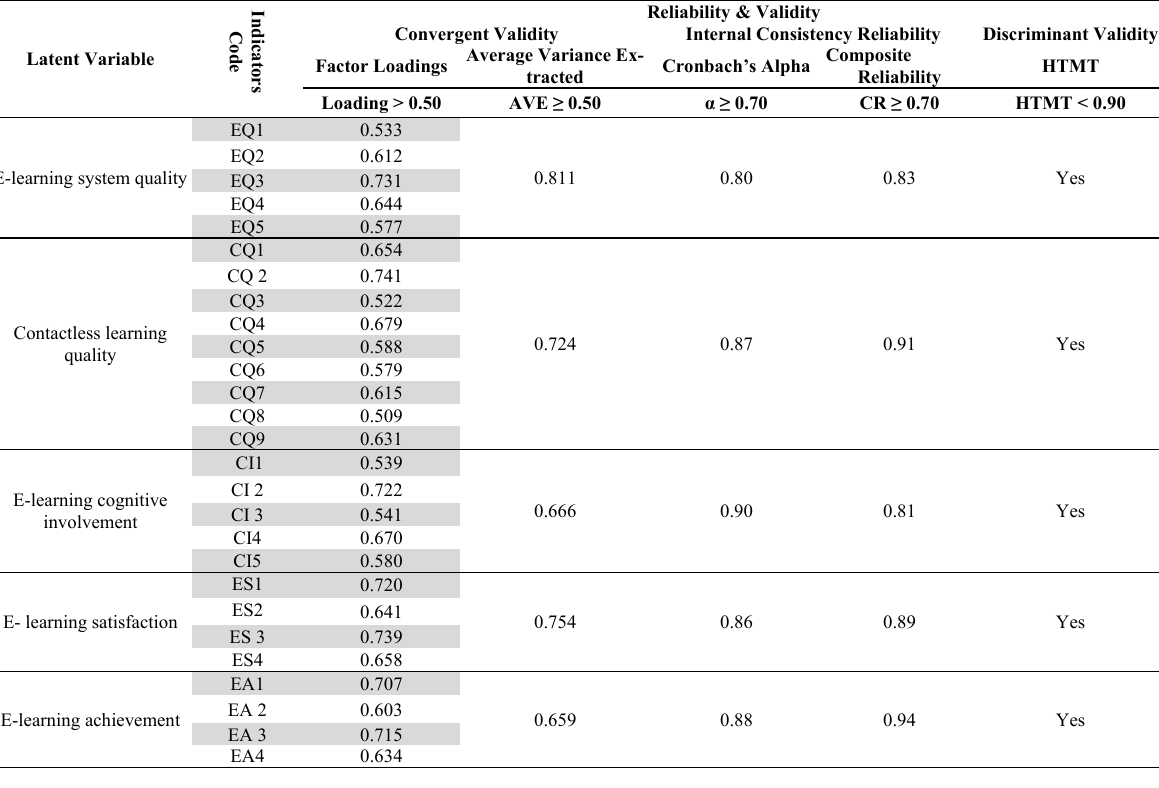
Factor Loading, Cronbach’s Alpha, CR, AVE and HTMT